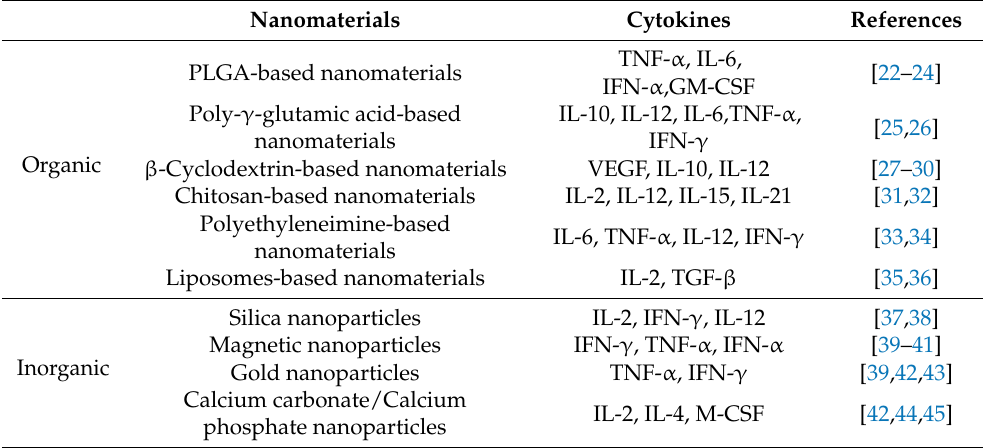
Table 1. Classification of nanomaterials and cytokines involved in the